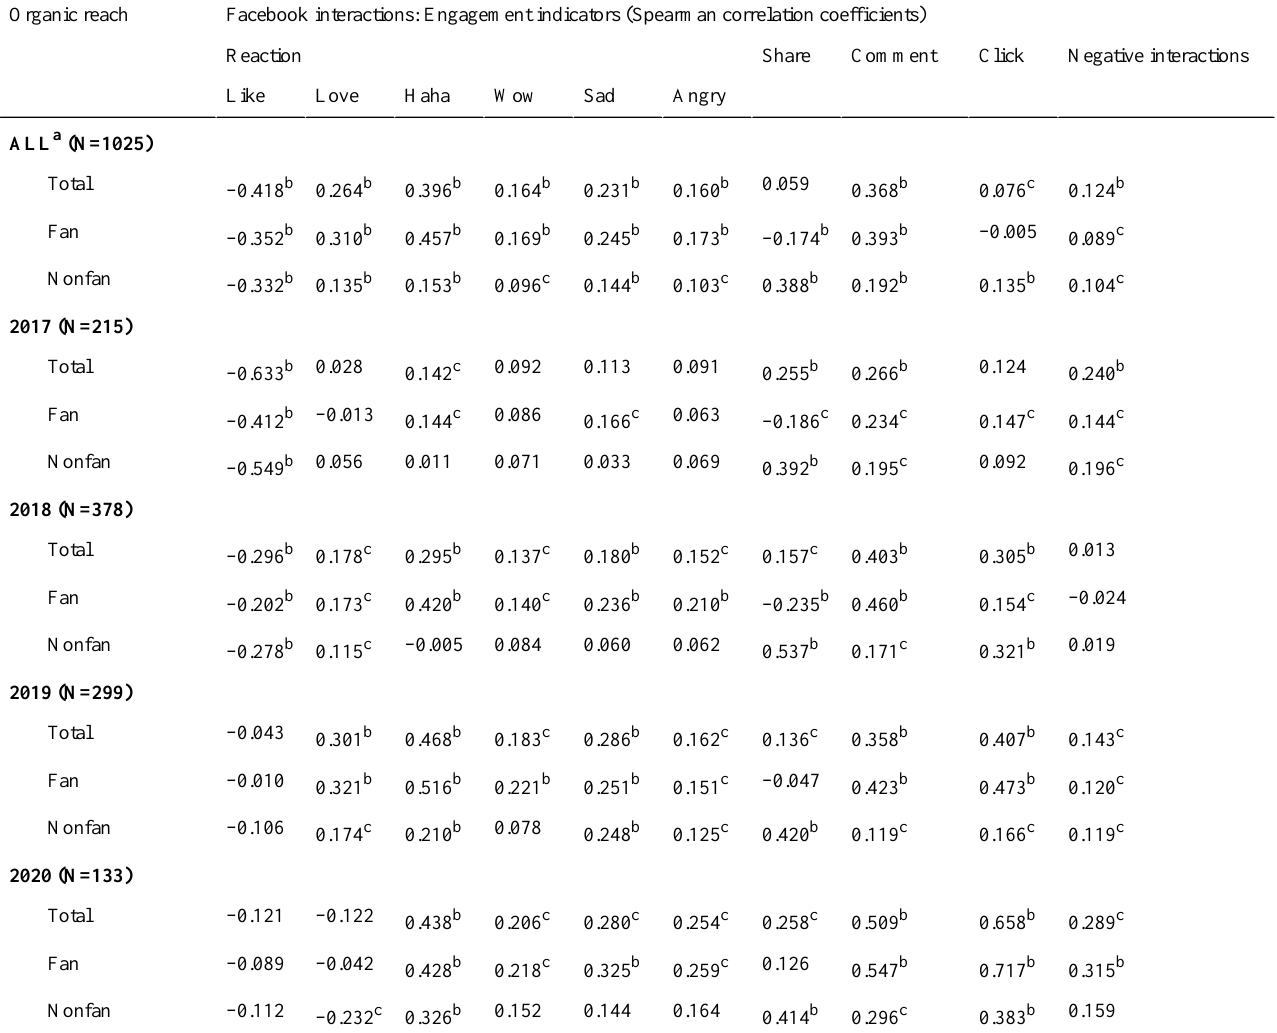
Table 2. Spearman correlation between Facebook interactions and organic reach in the research period together and separately for each year. Facebook interactions: Engagement indicators (Spearman correlation coefficients)Organic